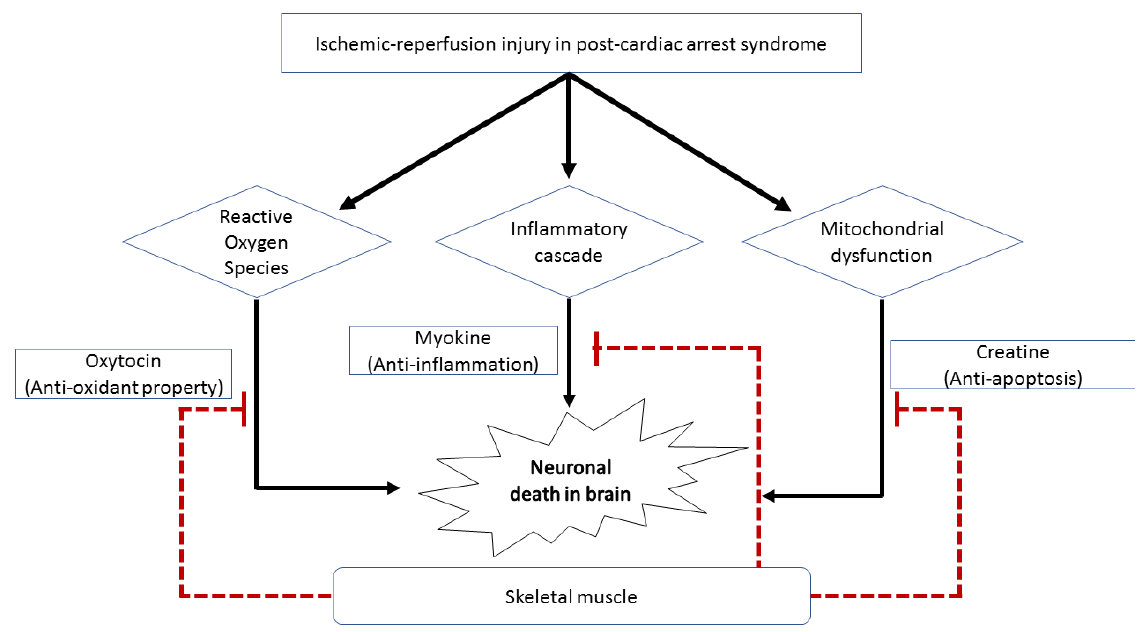
Figure 3. Schematic diagram showing the effects of skeletal muscle on the nervous system. Skeletal muscle can exhibit inhibitory effects on neuronal cell death in survivors after cardiac arrest via the (1) antioxidant property of oxytocin, (2) anti-inflammatory action of myokine, and (3) antiapoptotic activity of creatine.